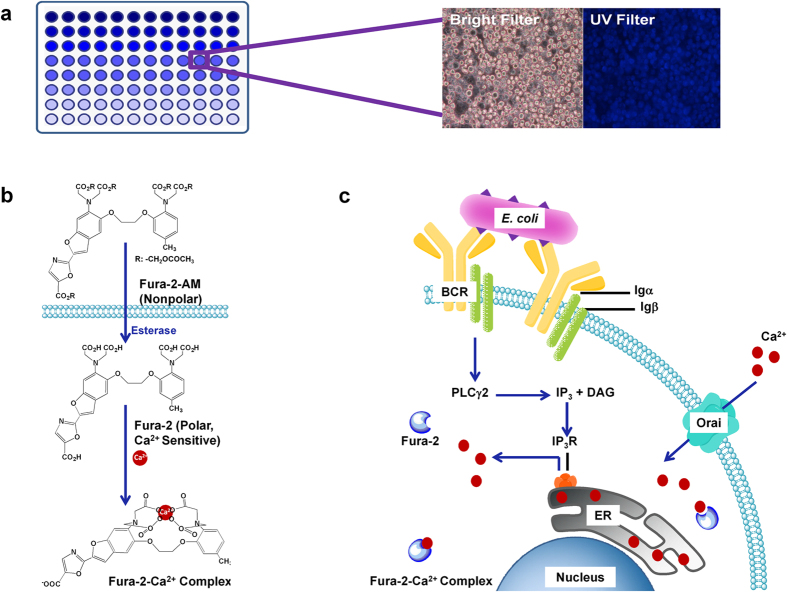
Principles of the B cell biosensor. (a). The response signal of the B cell biosensor was measured by a microplate reader. (b). Structural changes of Fura-2 by esterase activity and Ca2+ binding. Fura-2 AM ester is Ca2+ insensitive and nonpolar. Once inside the cell, esterase enzymes sequentially cleave the AM groups to leave Fura-2-free acid (Ca2+ sensitive, polar) trapped inside the cell, where it is able to bind Ca2+. (c). The cellular working principle of the B cell biosensor. When the target pathogen is attached to its specific receptors on the B cell surface, the cross-linking of B cell receptors (BCRs) will produce a signal, and the signaling pathways will be activated, resulting in the release of Ca2+ within seconds. Fura-2 exhibits a calcium dependent excitation spectral shift to report the 340/380 ratio and indicate the presence of the target pathogen.